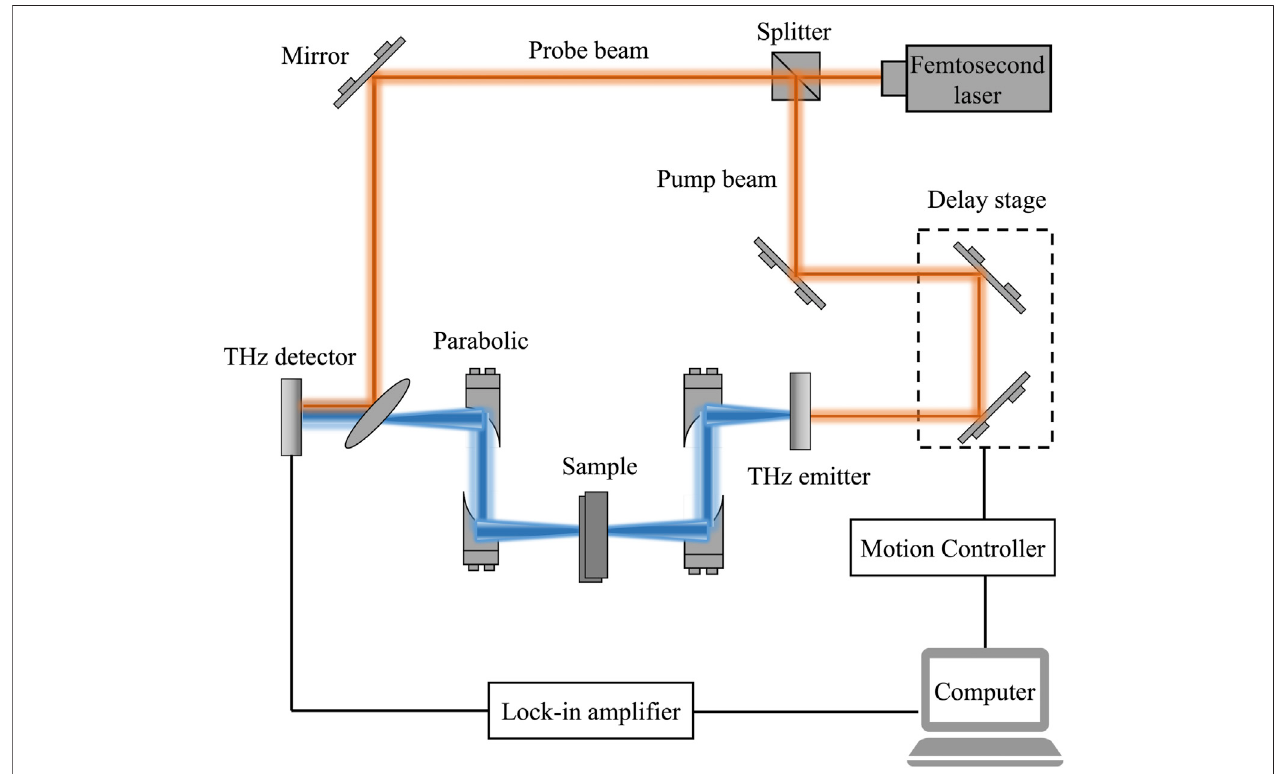
FIGURE 2 | Schematic of a typical transmission-type THz-TDS experimental setup